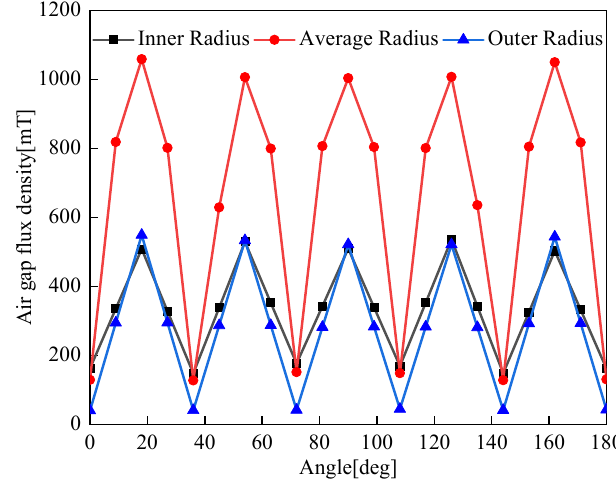
Figure 6. Air-gap magnetic densities at different radii.